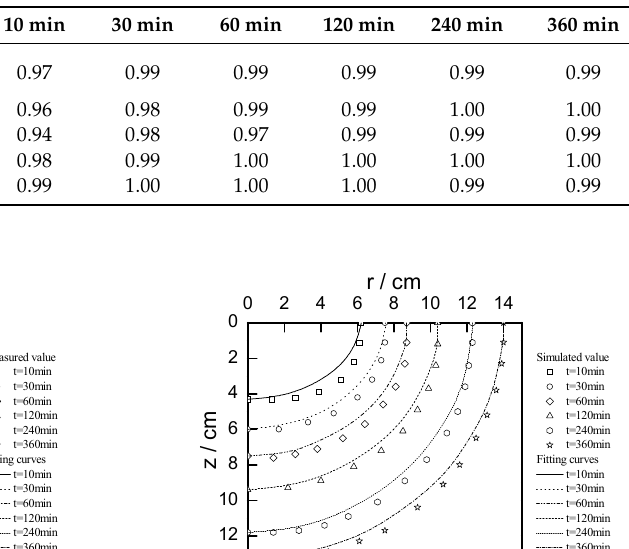
Table 2. Determination coefficients between wetting front and elliptic curve.